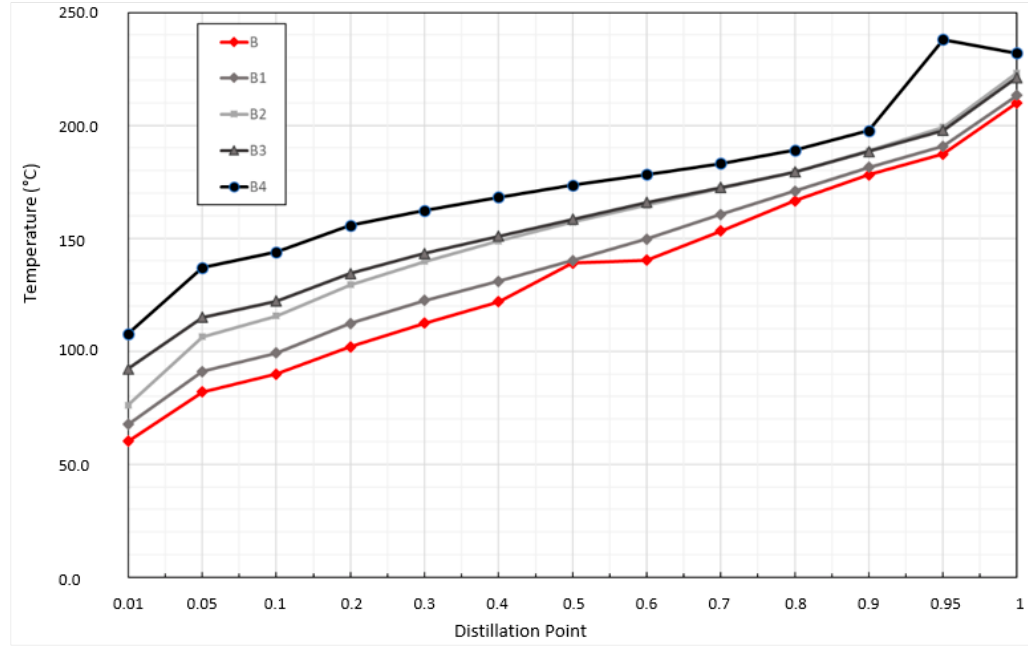
Figure 7. Distillation curves for the gasoline samples, measured in accordance with Methodology ASTM D287/ISO 3405: 2011 [38].